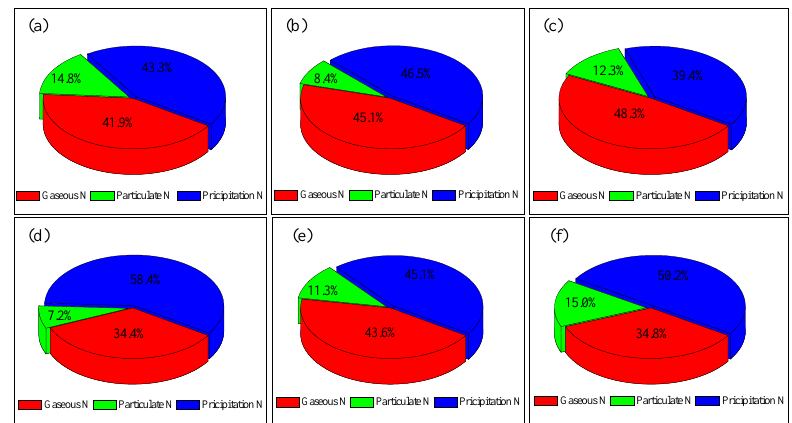
Figure 7. Contribution of different pathways (dry-deposited N = gaseous N + particulate N, wet/bulk-deposited N = precipitation N) to the estimated total N deposition in the six regions: (a) NC: north China; (b) NE: northeast China; (c) NW: northwest China; (d) SE: southeast China; (e) SW: southwest China; (f) TP: Tibetan Plateau.